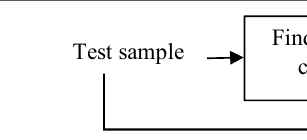
Fig. 3 Testing model for cluster-based regression